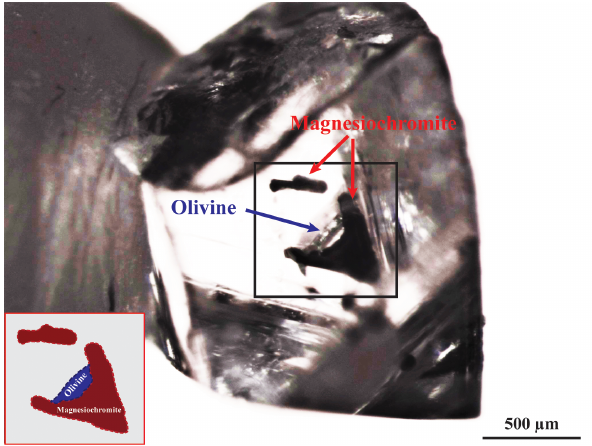
Figure 1. Close-up photograph of the Oli-CHR1 diamond shows the studied mchr–olivine inclusion pair (see also the simplified sketch of the inclusion pair, bottom left corner) and a separate elongated mchr inclusion. The larger crystal is principally cuboctahedral in shape, and both mchr inclusions are deep cherry red. The colourless olivine inclusion is attached to the larger mchr crystal, as